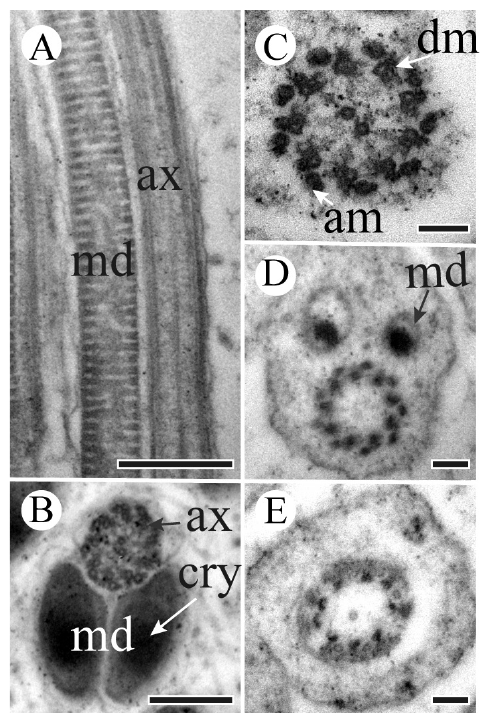
Figure 4. TEM micrographs of S. yangi sperm tail region. A Longitudinal section of sperm tail, show- ing axoneme (ax) and mitochondrial derivative (md) B Cross-section through the tail region, showing axoneme (ax) and mitochondrial derivatives (md) with crystalline region (cry) C Magnified cross-section of axoneme (ax), showing axoneme with a normal 9 + 9 + 2 arrangement of microtubules, i.e., 9 acces- sory microtubules (am), 9 double microtubules (dm) and 2 central microtubules D Cross-section of the terminal end of the sperm tail, showing paired mitochondrial derivatives (md) and axoneme (ax) with 9 accessory microtubules and 9 double microtubules left E Cross-section of the terminal end of the sperm tail, showing parts of microtubules of axoneme left. Scale bars: 500 nm ( A ), 200 nm ( B ), 100 nm ( C–E